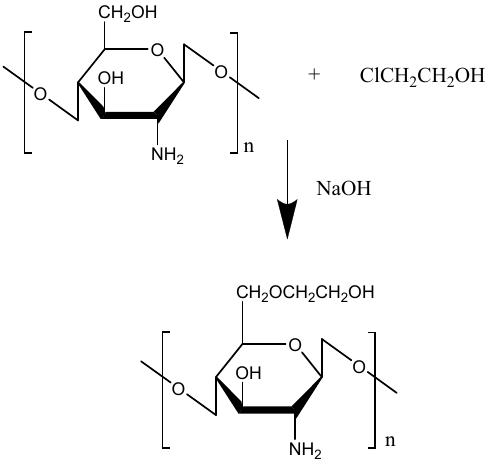
Figure 3. Reaction scheme of glycolated chitosan.